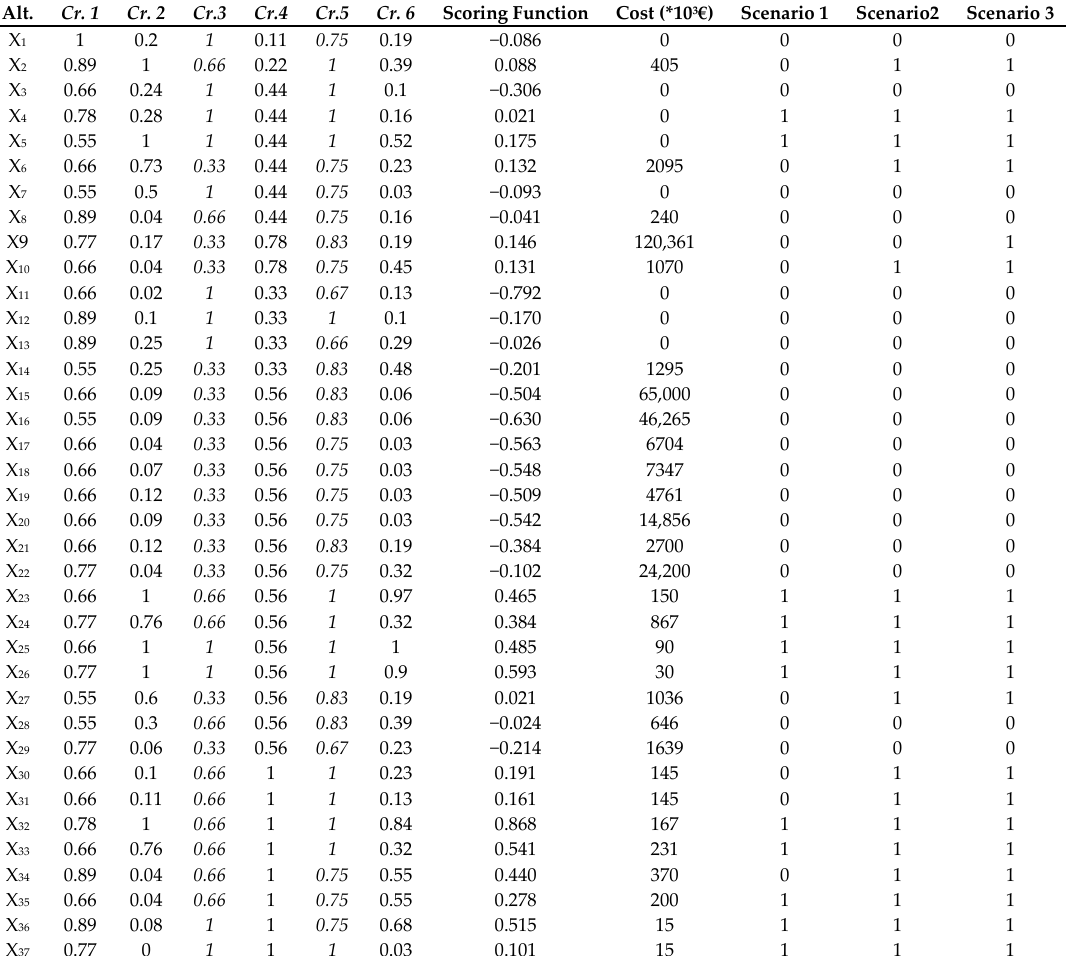
Table 2. Estimation of the score of alternatives ( Cr.1 to Cr.6 ), values of their scoring function, and the final solution for proposed scenarios regarding the available